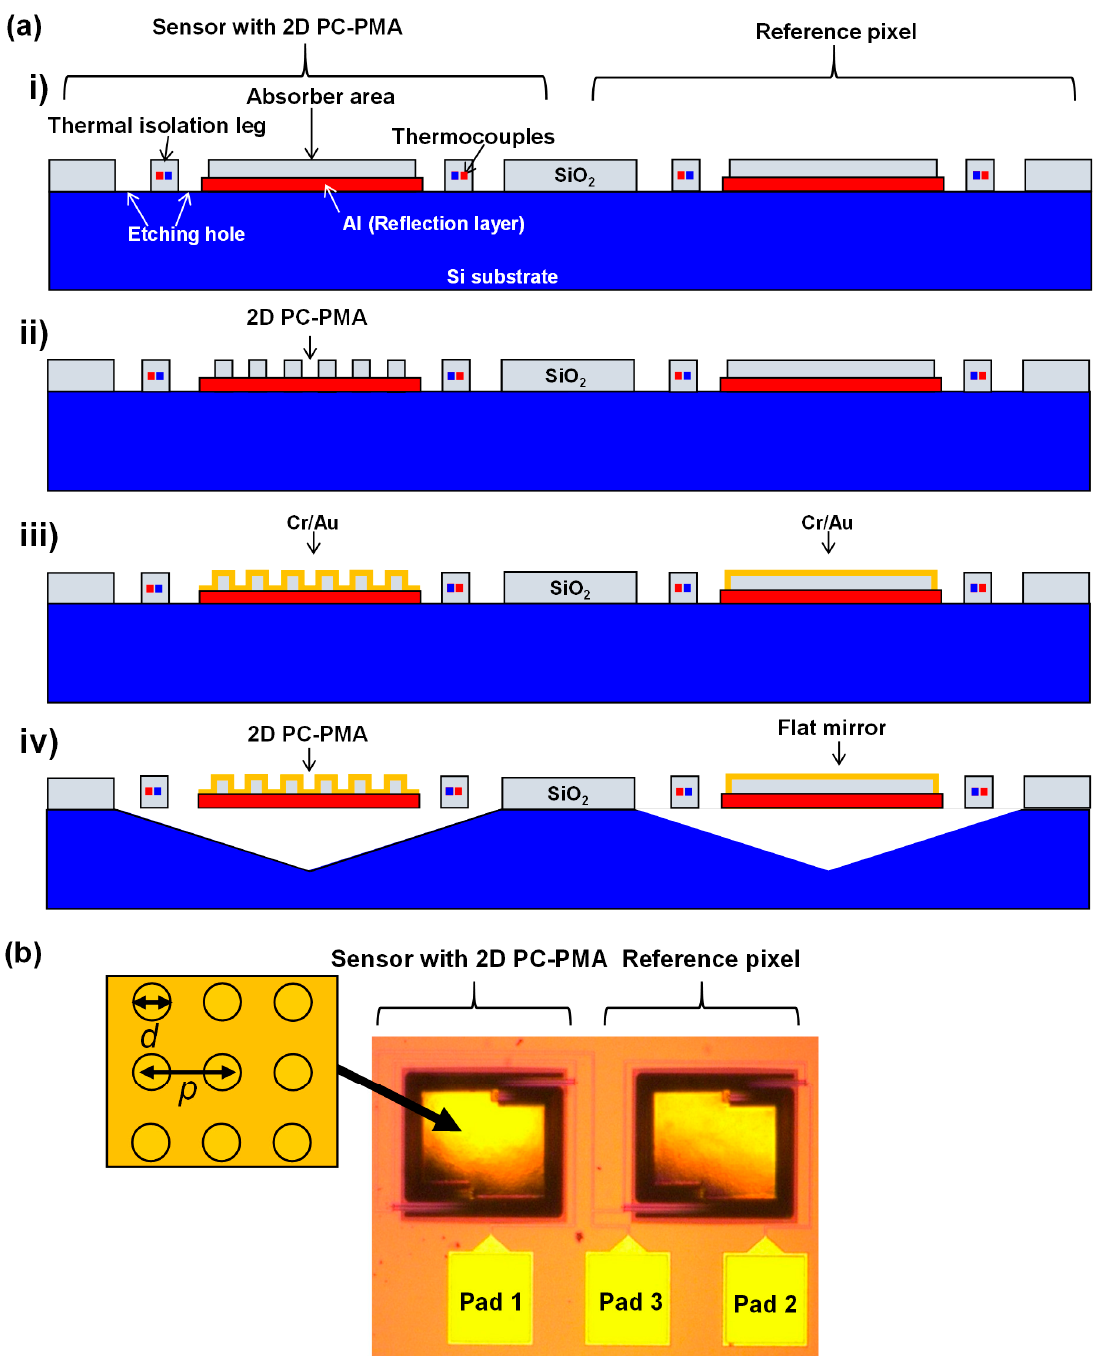
Figure 5. ( a ) Fabrication procedure of a MEMS-based thermopile with PMAs and a reference pixel. ( b ) Optical microscope image of the developed sensor with PMAs and the reference pixel.